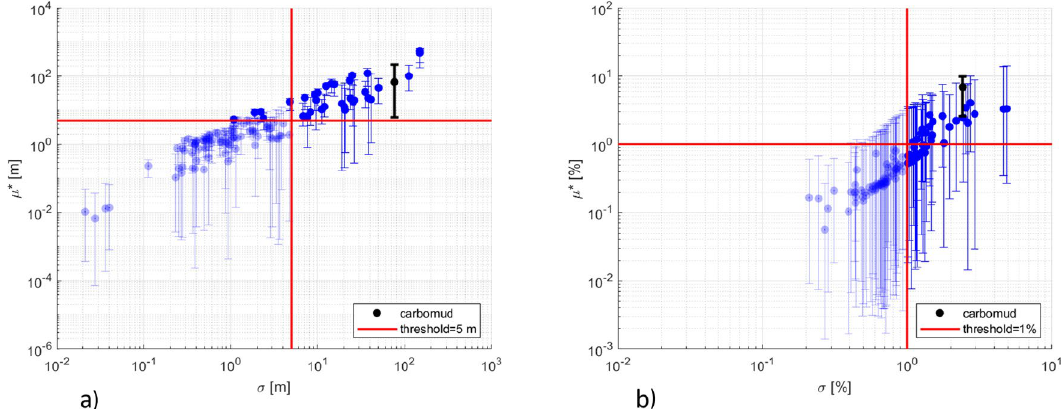
Figure 4. Sensitivity indices µ ∗ versus σ at 89 Ma for Z ( a ) and in the age interval 89–66 Ma for V sand ( b ). Red lines indicate the selected thresholds. Solid points are the spatial average values of µ ∗ and σ for each of the model parameters, error bars indicate the 5th and 95th percentile of the index µ ∗ evaluated in the spatial domain. Results related to parameter #71 are highlighted in black. Parameters whose average indices are below the thresholds are shown half-transparent.